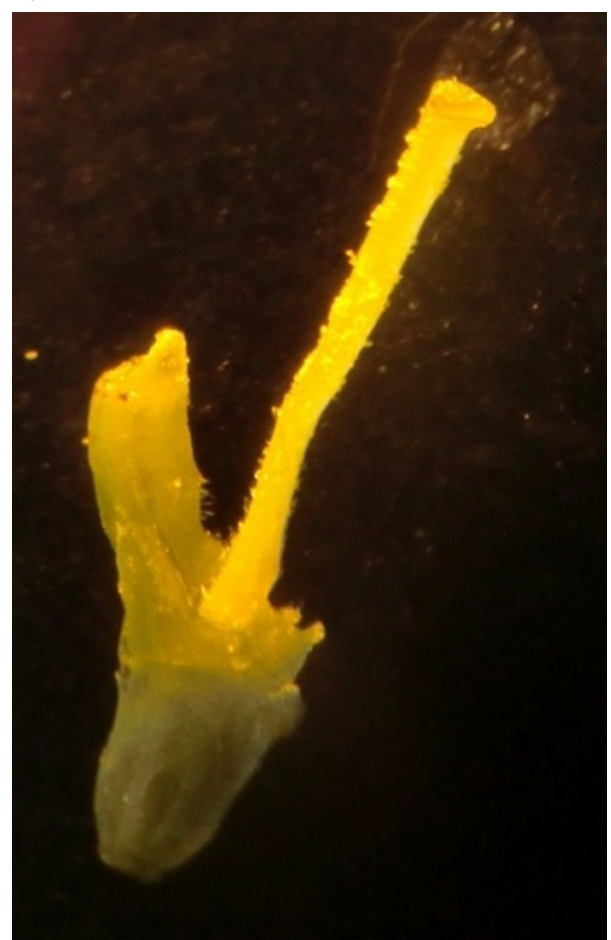
Fig. 2. Intact pistil (0.5 mM SA and -4°C artificial cold stress)